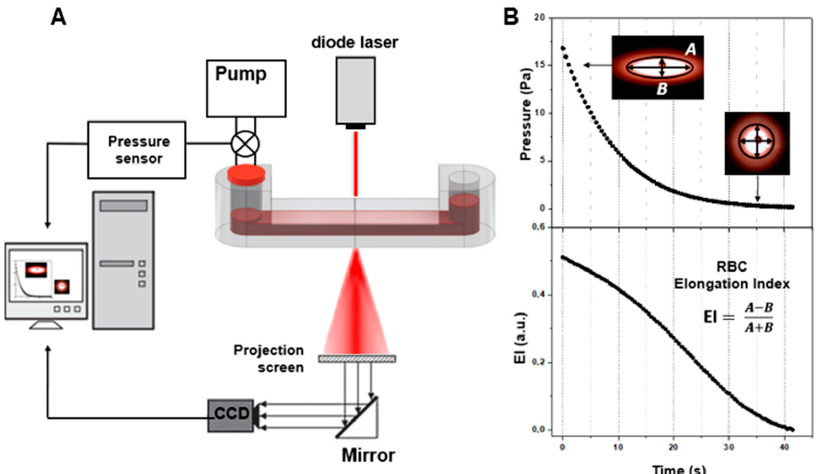
Figure 5. Schematic representation of laser diffractometry for assessing RBC deformability. ( A ) Schematic layout of the experimental setup utilizing the fluidic chip with the microchannel filled with 300 times diluted blood under shearing stress illuminated with a laser (637 nm) source; ( B ) formation and analysis of diffraction patterns, and assessing RBC deformability in terms of the elongation index (EI), which is dependent on shear stress.